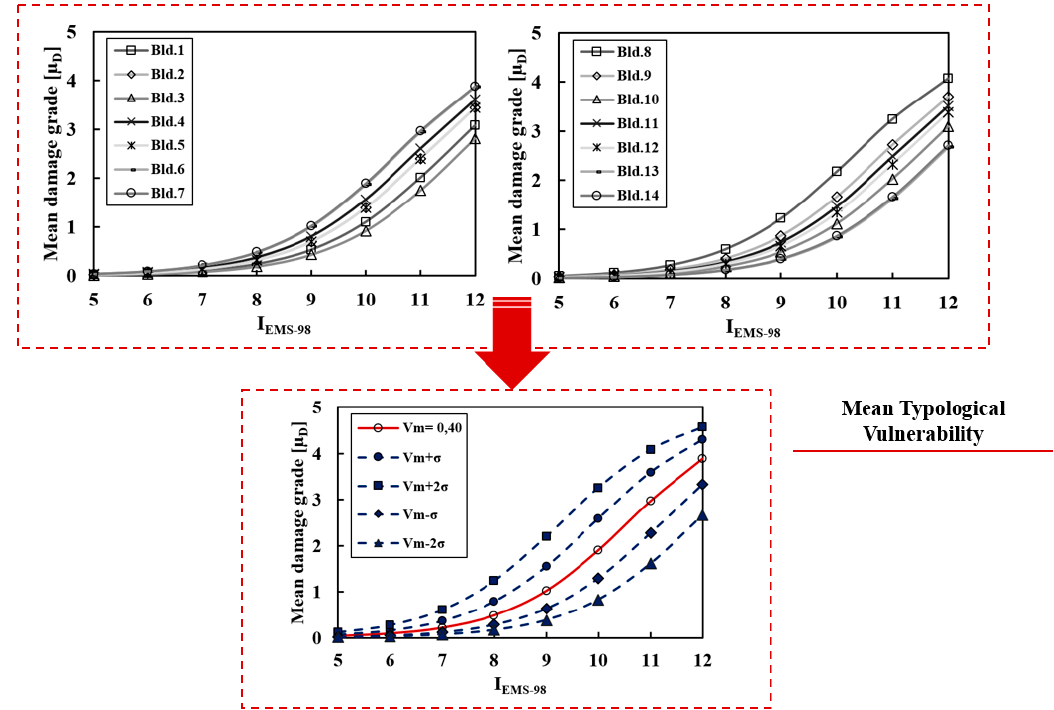
Figure 6. The mean typological vulnerability curves for examined buildings.